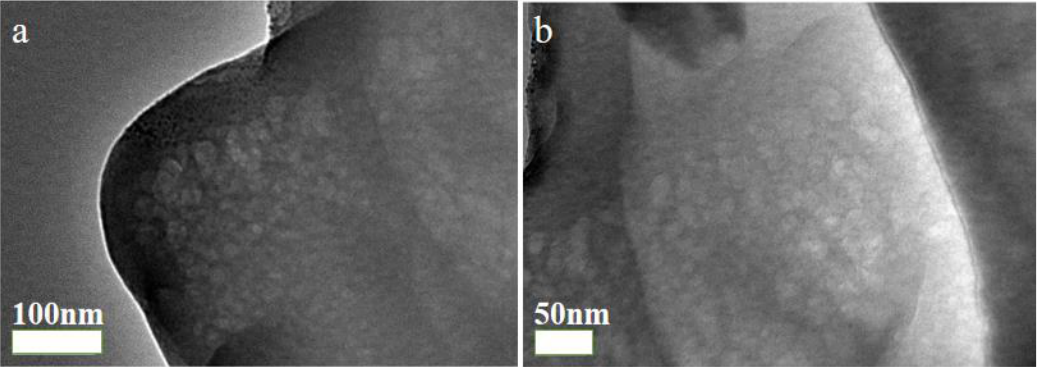
Figure 1. ( a ) SEM images of BC membrane. ( b ) BC adhesive PDA composite membrane. ( c ) TiO 2 composite membrane was supported by BC adhesive PDA and ( d ) BTA.